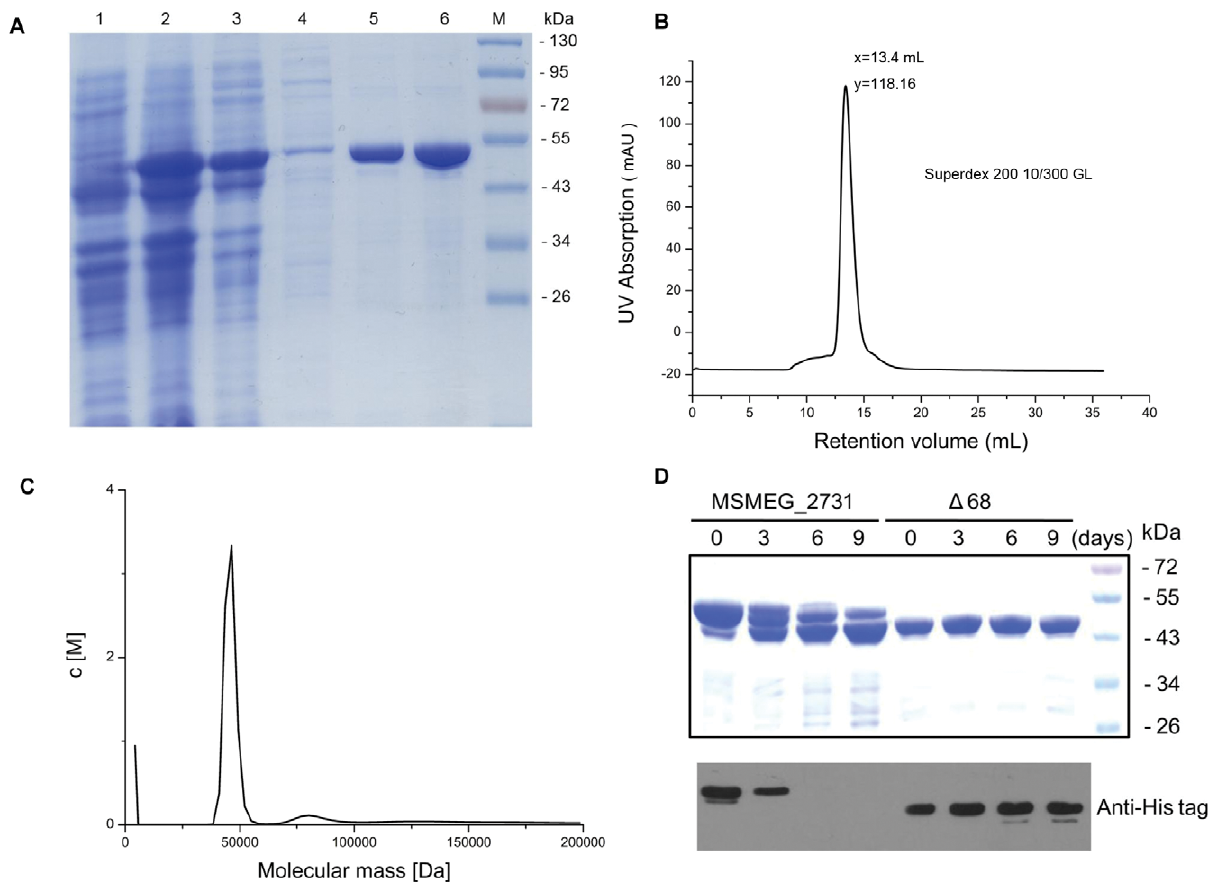
Figure 1. Purification and characterization of MSMEG_2731. (A) Purification of MSMEG_2731 by nickel affinity chromatography. Lane 1, BL21/ pET28a- MSMEG_2731 prior to IPTG induction, lane 2, BL21/pET28a- MSMEG_2731 after IPTG induction, lane 3, the supernatant of the cell lysate after sonication, lane 4, sample after washing with buffer containing 30 mM imidazole, lane 5 and 6, two consecutive elutions with 250 mM imidazole. (B) A280 profile from gel filtration chromatography of recombinant MSMEG_2731 on a Superdex 200 10/300 column. The peak fraction was collected